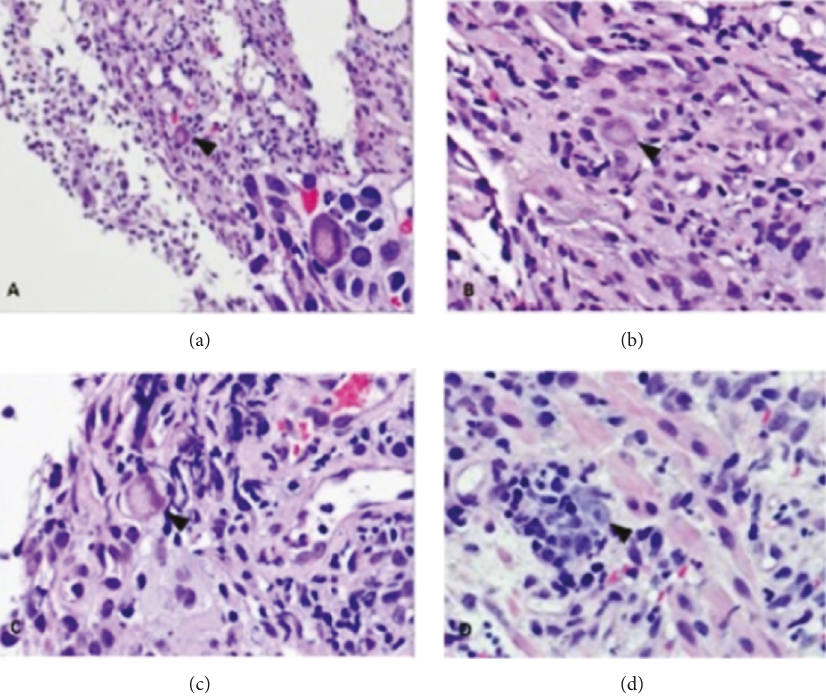
Figure 3: Biopsies from terminal ileum. (a) 200x and 500x (inset) H&E stained appearance of CMV-infected cells. (b) 400x H&E stain showing a cell with CMV cytopathic effect. (c) 500x H&E stain showing a cell with another variation of CMV cytopathic effect. (d) 500x H&E stain with another example of CMV cytopathic effect. The nucleus contains a viral